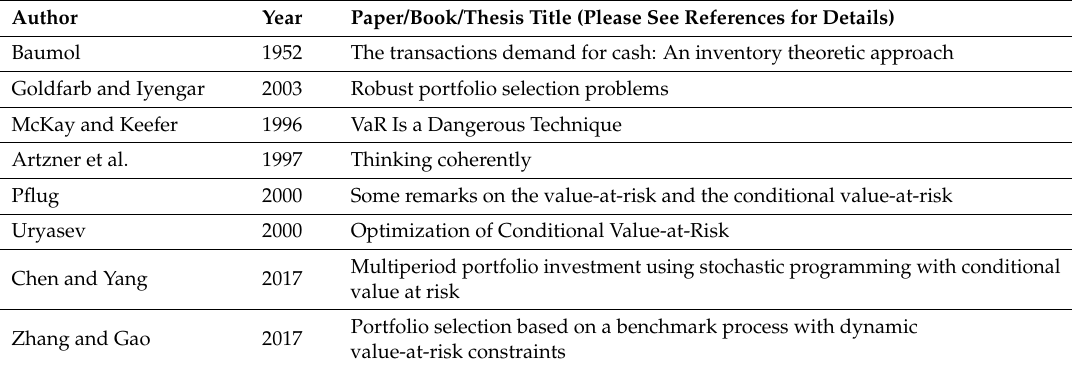
Table 4. Selected work on Portfolio Selection and